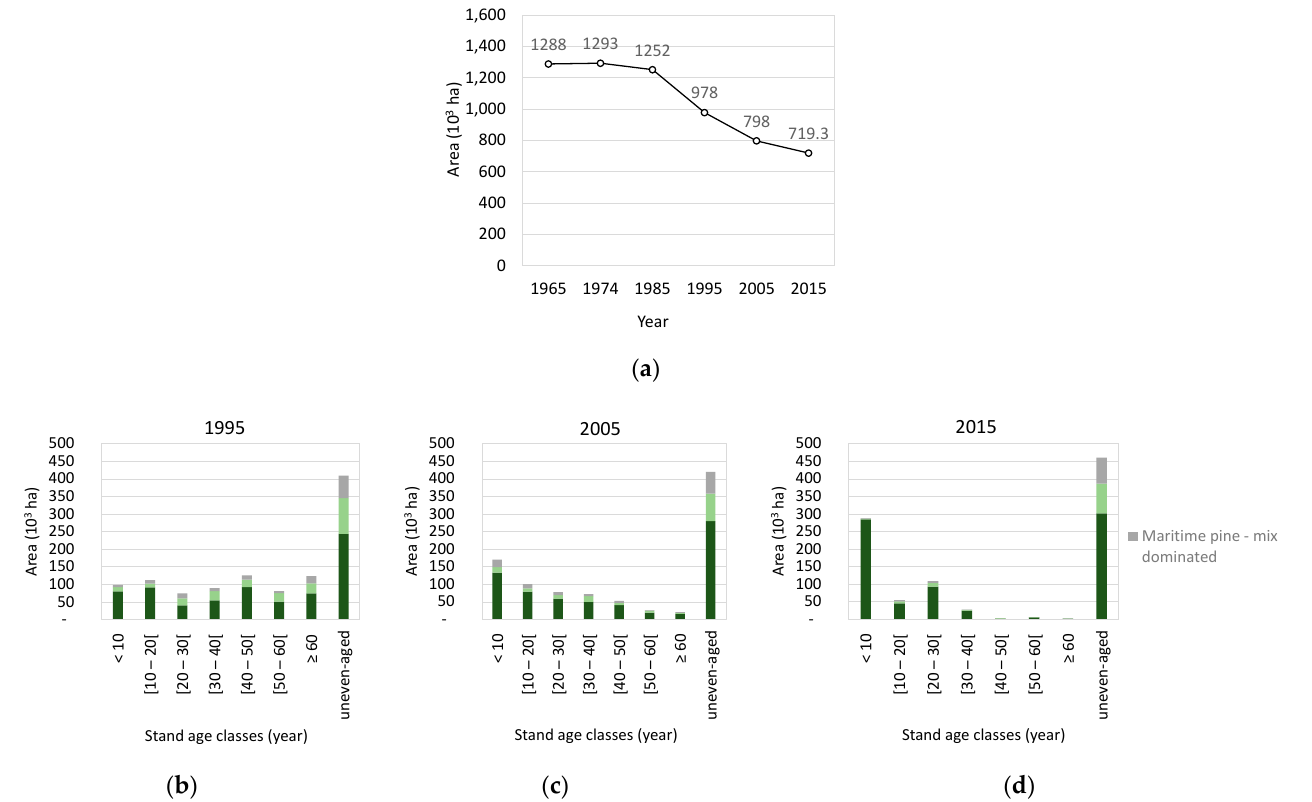
Figure 8. Maritime pine forest National Forest Inventory statistics. ( a ) Area (1965–2015); ( b ) area by stand age classes (1995); ( c ) area by stand age classes (2005); and ( d ) area by stand age classes (2015).